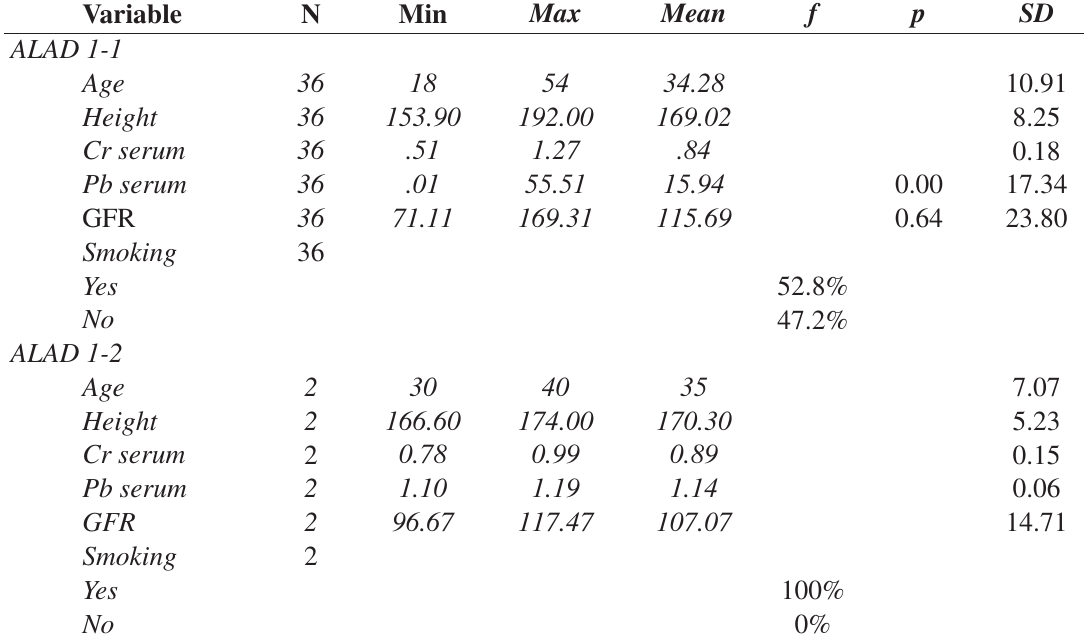
Table 2. The characteristic of respondents by ALAD Polymorphism